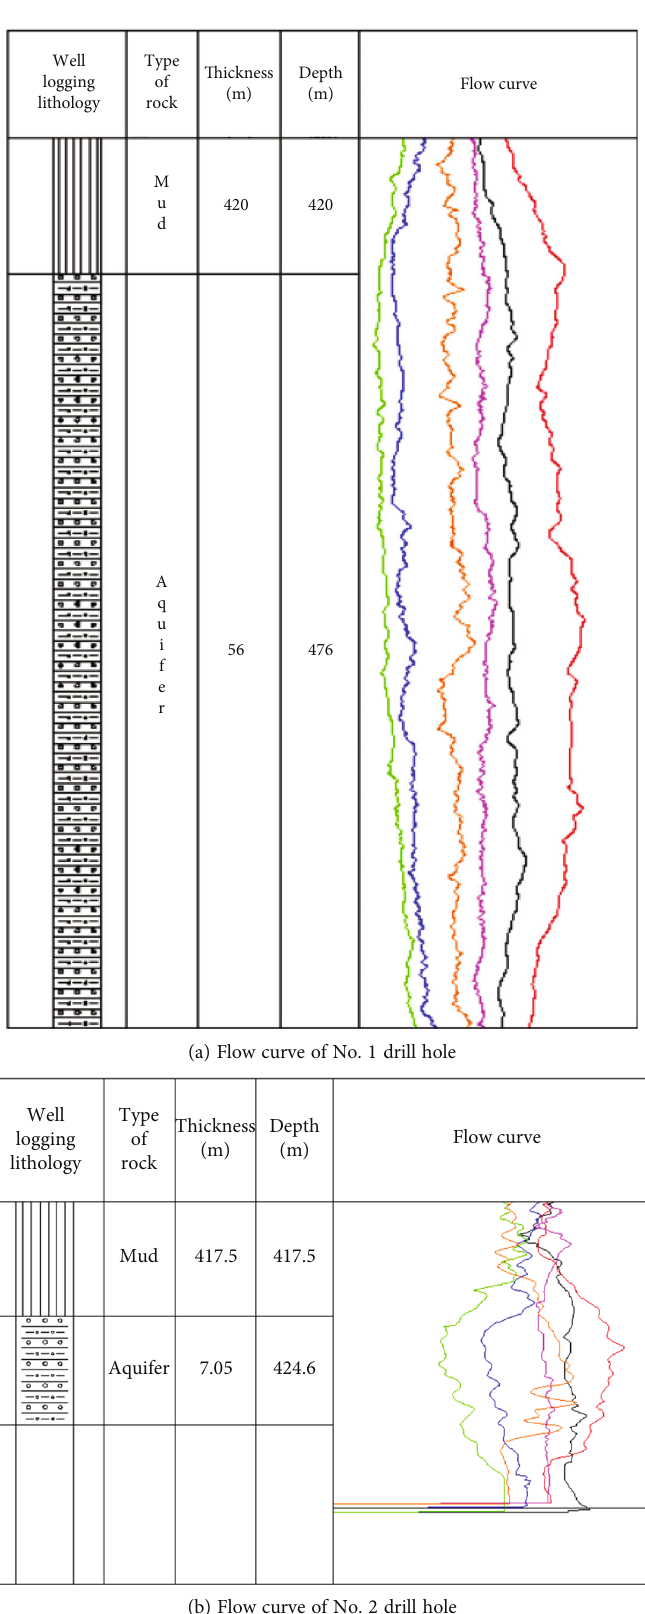
Figure 8: Flow curve of No. 1 and No. 2 drill